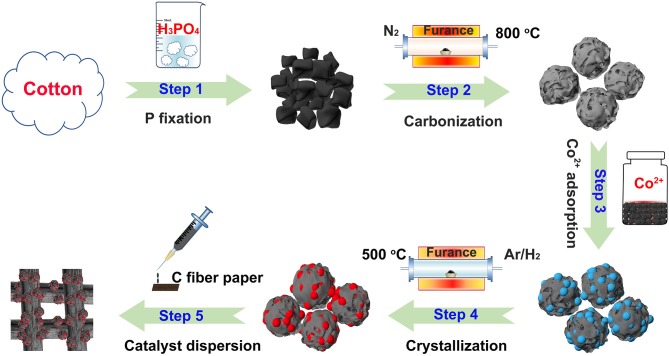
Schematic diagram of process to prepare Co2P/C catalyst.